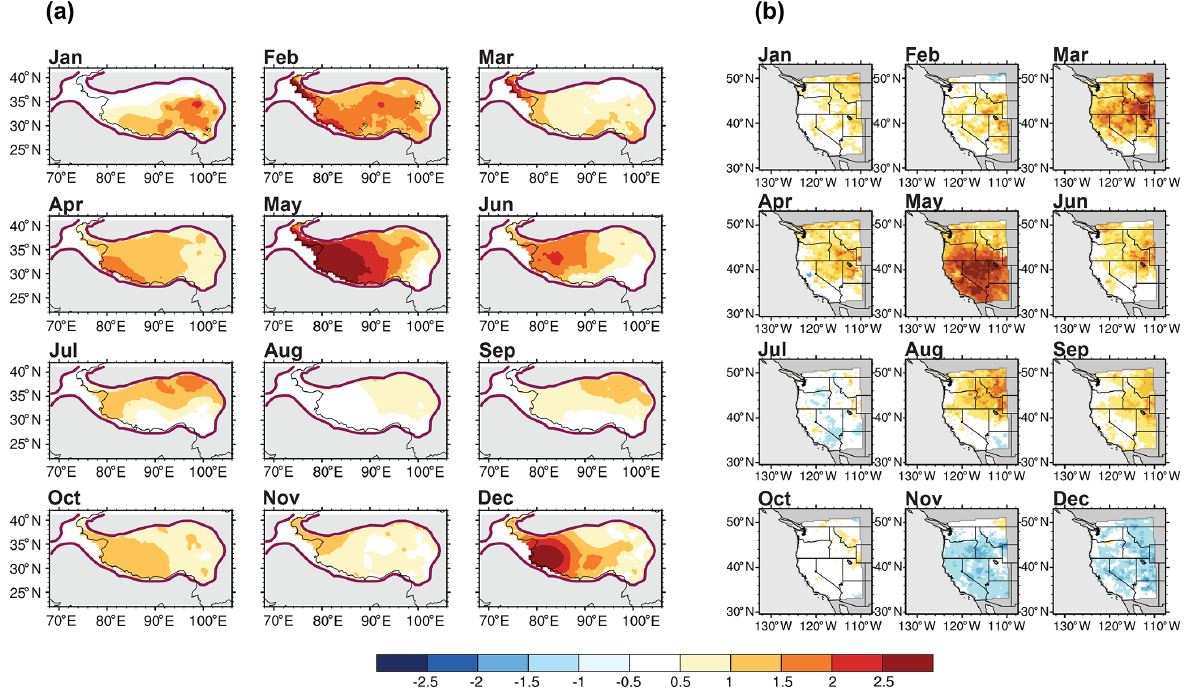
Figure 1. Monthly 2m temperature difference between warm and cold years ( ◦ C). (a) Over the Tibetan Plateau based on the CMA data; (b) over the western US based on NARR data. Notes. (1) Years for the Tibetan Plateau and western US are selected based on their May anomalies, respectively, using a threshold of 0.5 standard deviation during the period 1981–2010. The differences between these warm and cold years are applied for all months. (2) The North American Regional Reanalysis (NARR, Mesinger et al., 2006) assimilated the observed 2m temperature and is viewed as having an accurate representation of the observed surface air